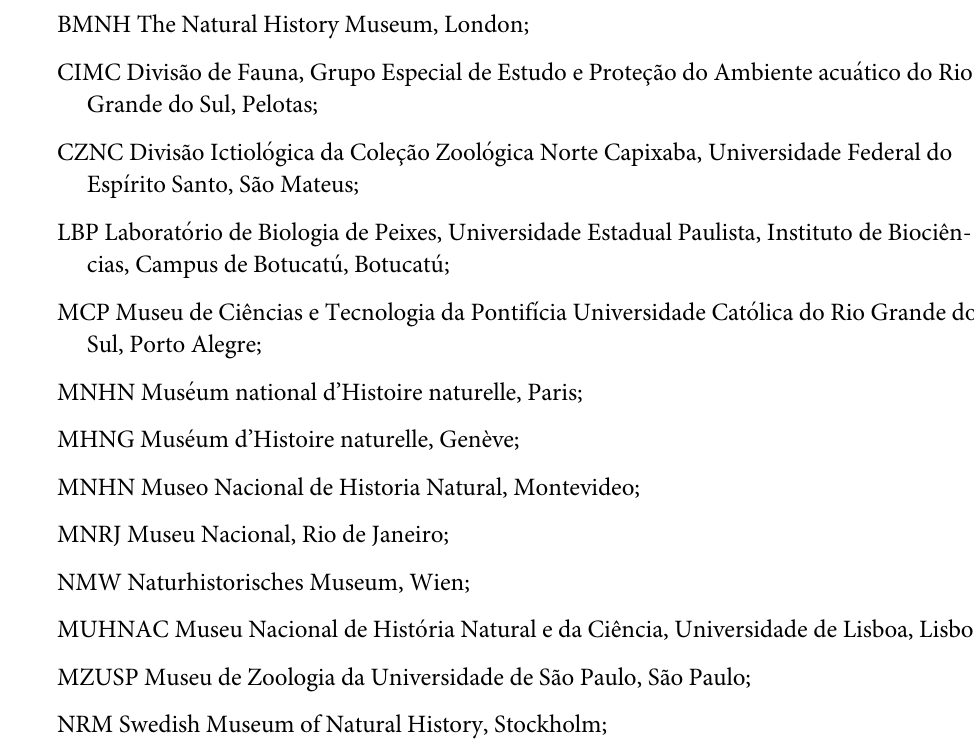
Fig 1. Sampling sites of coastal species of Australoheros . A symbol may cover more than one sampling site.